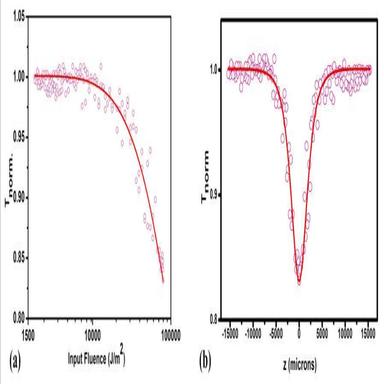
Open aperture Z-scan curves of GuHM (a) Normalized transmittance vs input laser fluence (b) Normalized transmittance vs z-position. The numerical fits to the data are shown by the solid curves.